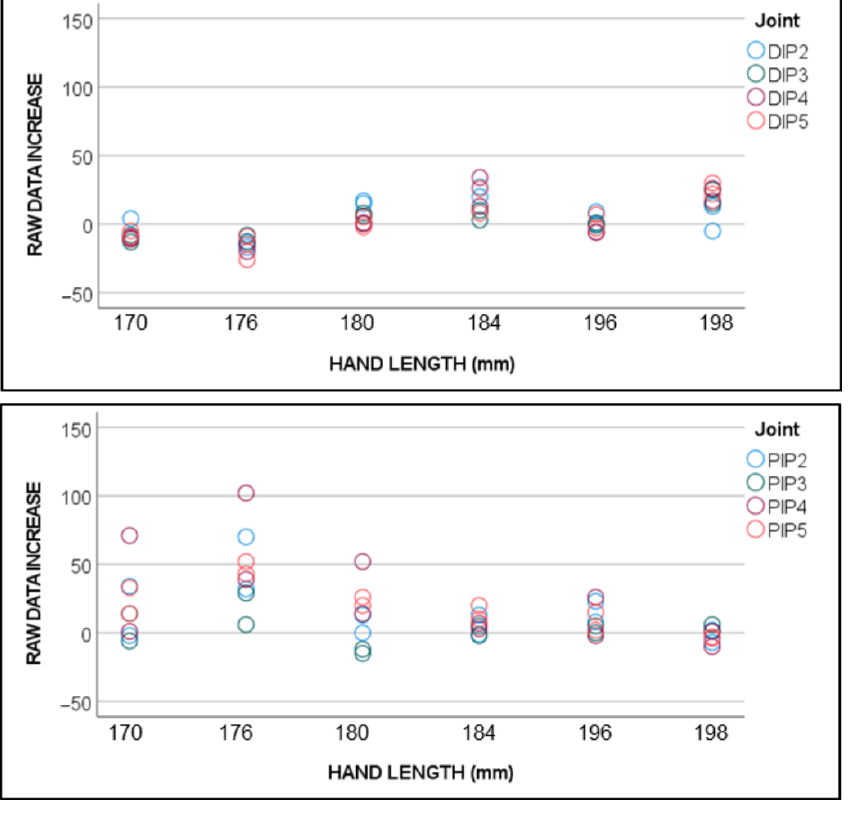
Figure 5. Increases in the raw data values in gauges, which were assumed to remain in flexion = 0. Color legend: index finger DIP (DIP2) in blue, middle finger DIP (DIP3) in green, ring finger DIP (DIP4) in red, and little finger DIP (DIP5) in orange.